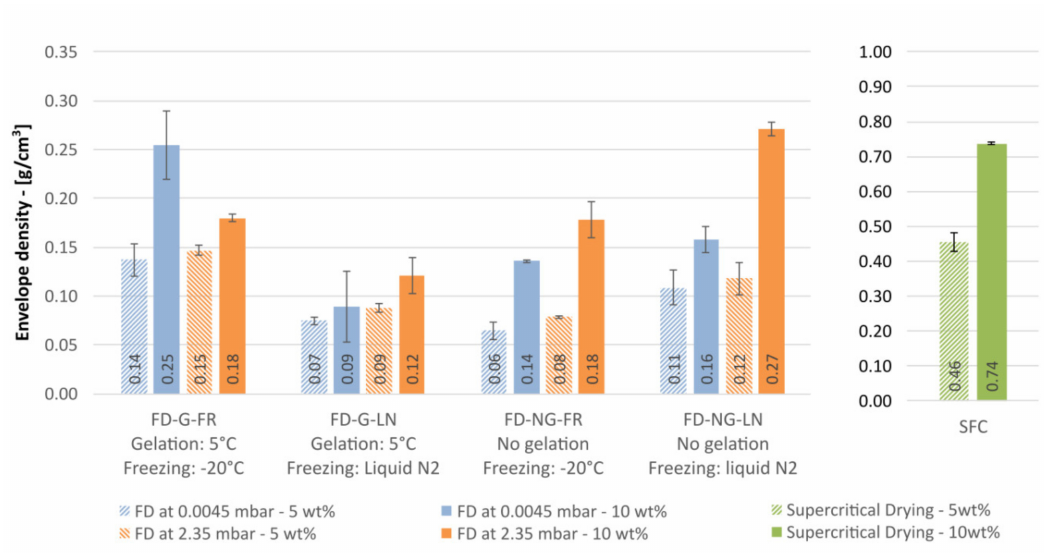
Figure 10. Envelope density comparison of freeze-dried and supercritically dried samples for starch concentration of 5 w% (hashed bars) and 10 wt.% (plain bars).